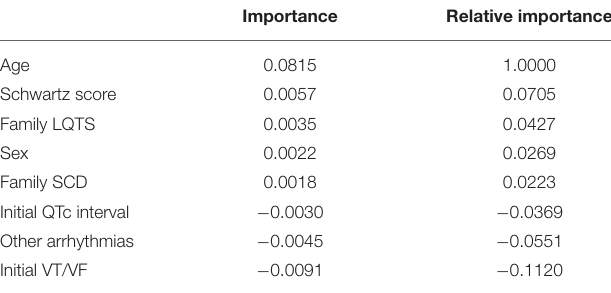
TABLE 3 | Variable importance ranking to predict VT/VF post-diagnosis with RSM